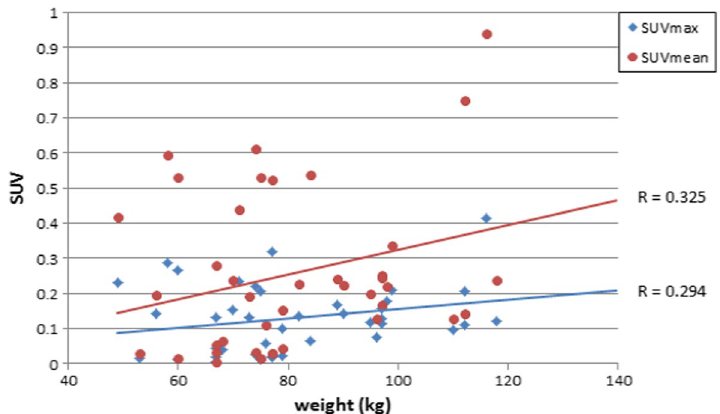
Fig. 6 Pearson correlation coefficient between Lesion SUV versus patient’s weight in kg with respect to BSA